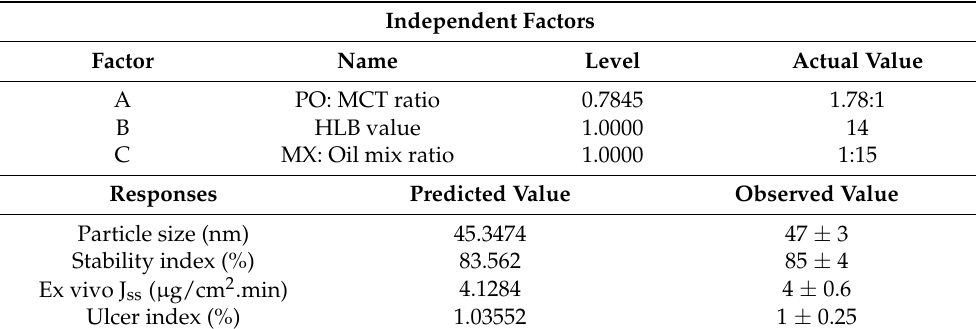
Table 9. Optimum formula suggested for the MX-PO-SNEDDS formulation and the predicted and observed responses for the optimized formula.